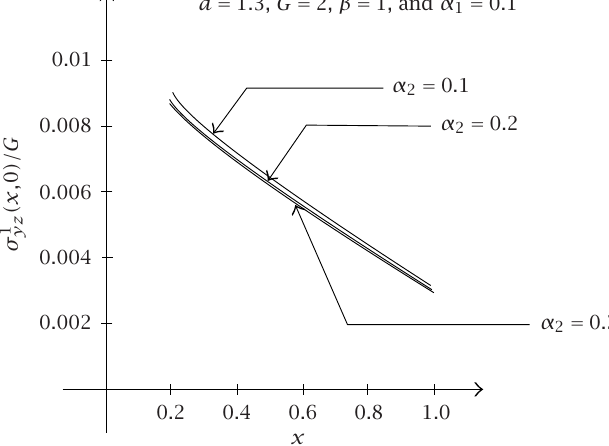
x for different values of 1 with = 0 . 1, and β = 1